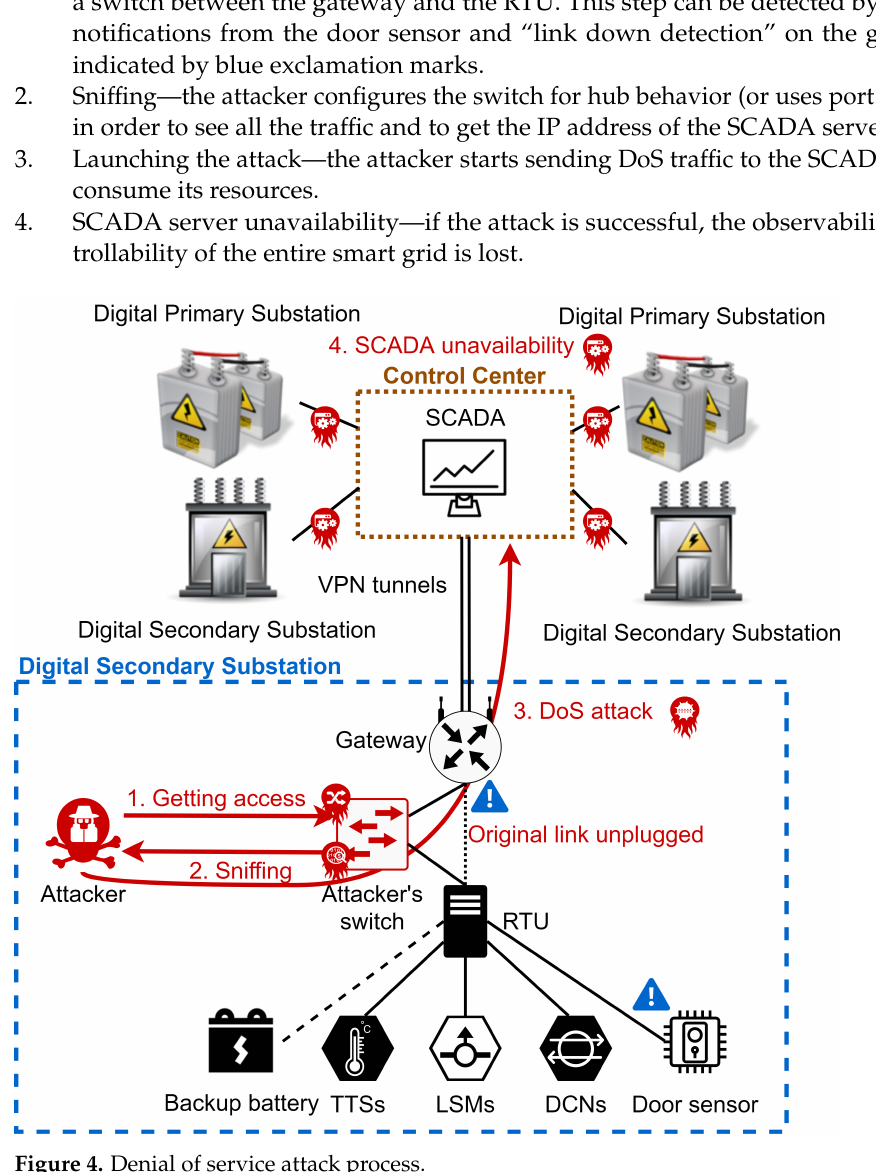
Figure 4. Denial of service attack